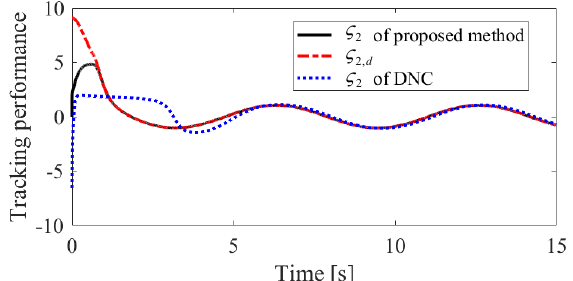
Figure 8. Tracking performance of ς 2, d in Case 2.